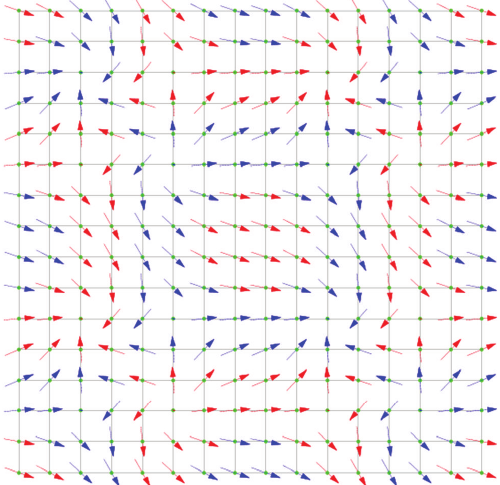
Figure 4: ( Color online ) The ground state configuration for V = 7 . 0 and U = 8 . 0.